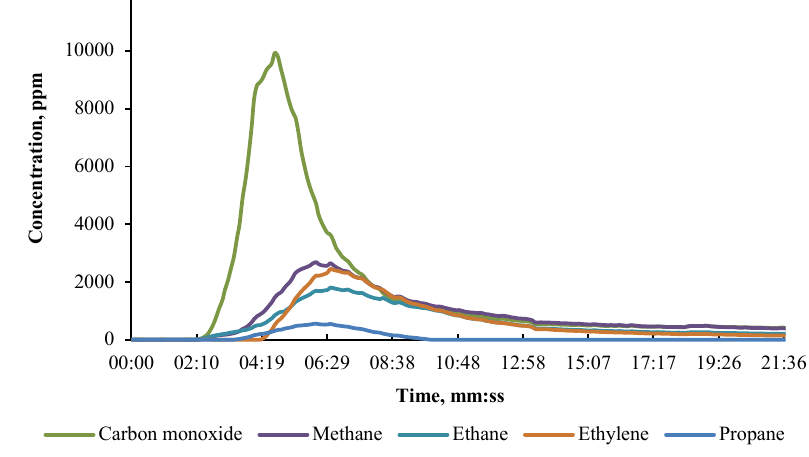
Fig. 4. Evolution of different gases during oil shale and biomass co-pyrolysis at 550 °C in the fixed bed